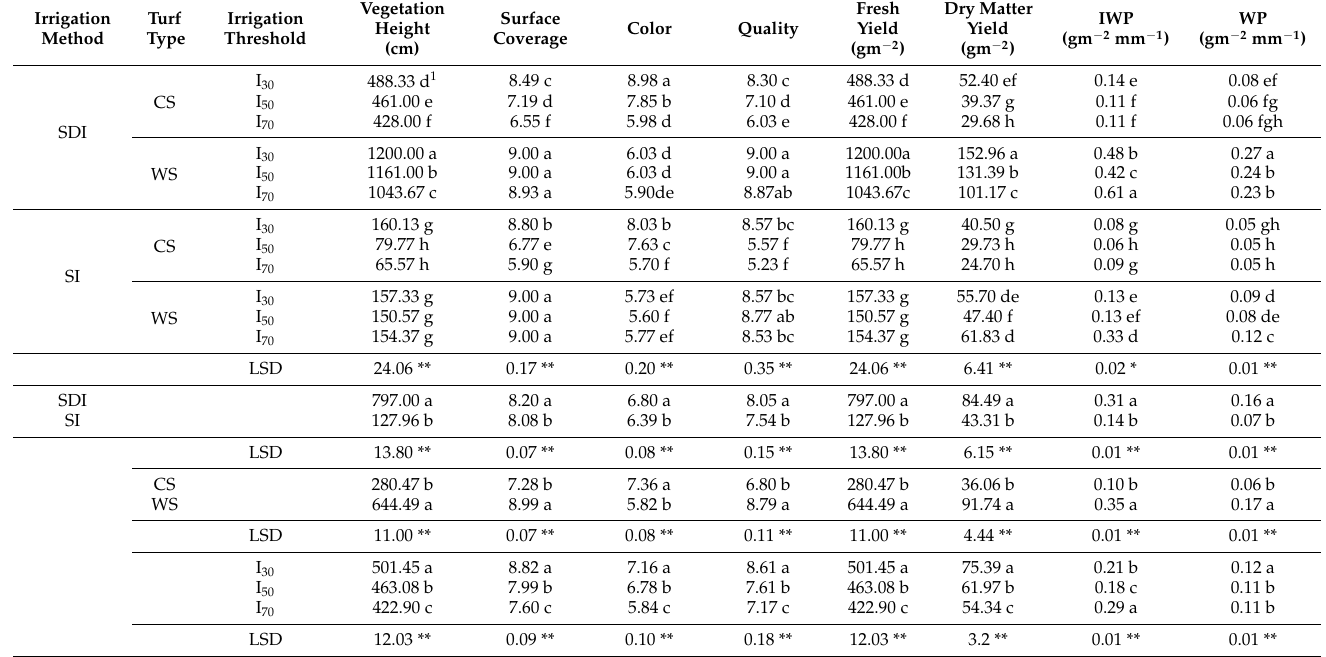
Table 4. Some growth and quality parameters of turf and water use efficiencies for all treatments in the year of